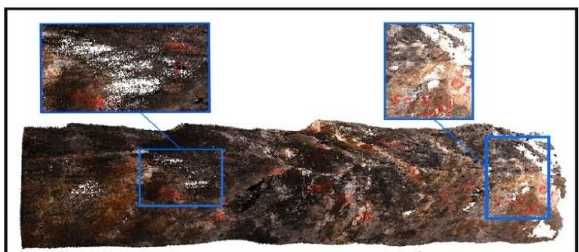
Figure 10. An example of a single-line 3D reconstruction based on deep learning (side wall).